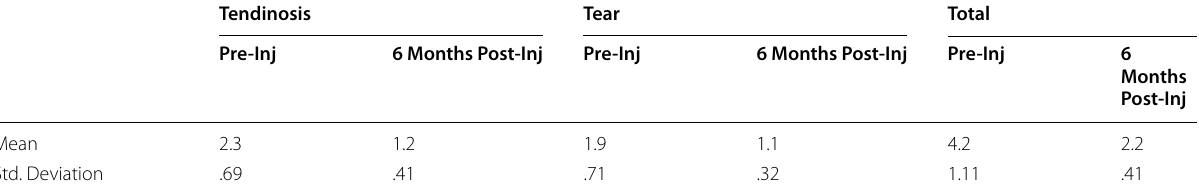
Table 4 Tendinosis, tear and total scores pre and 6 months